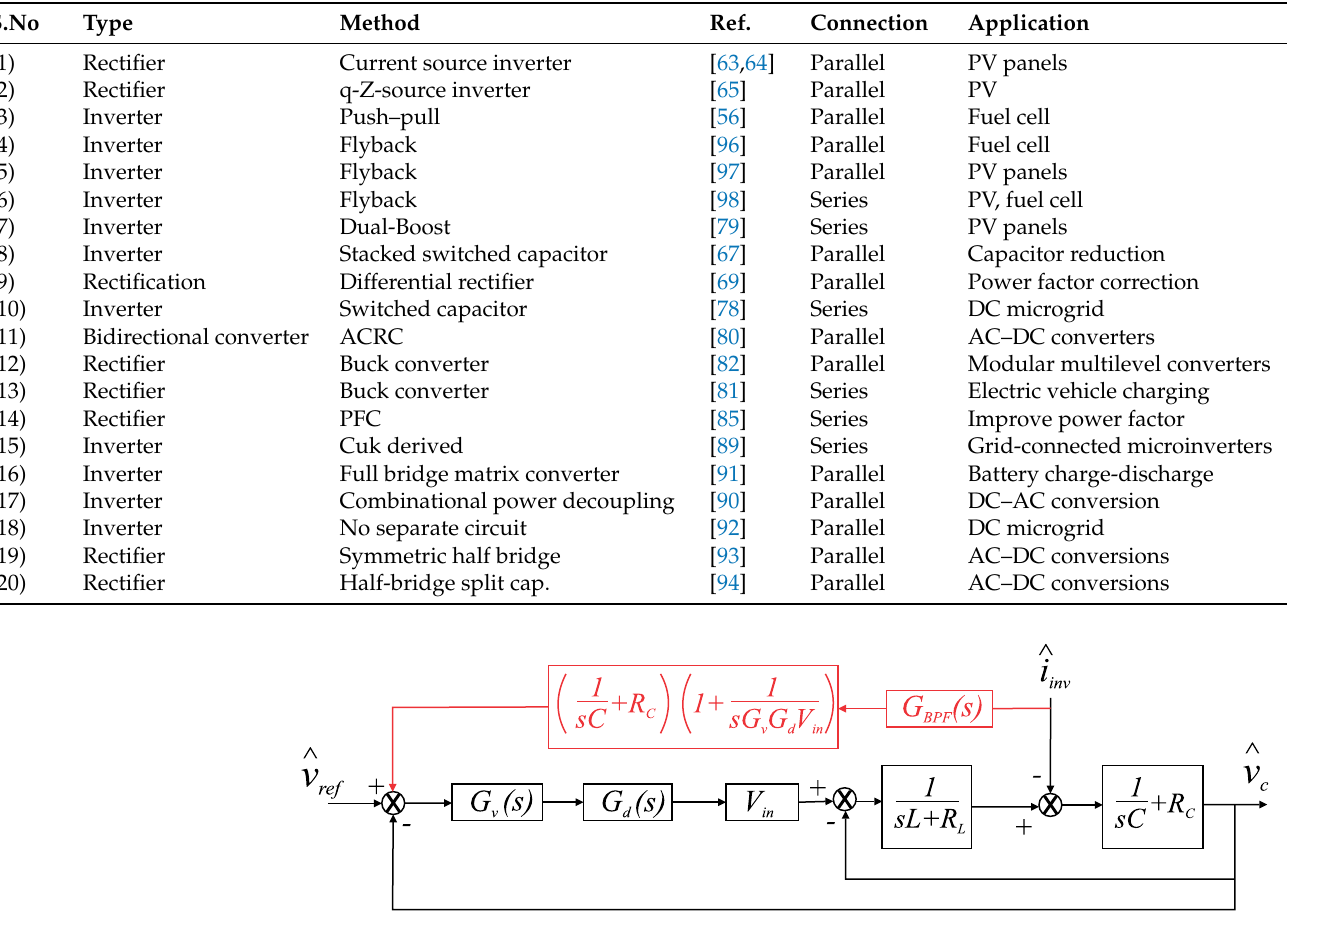
Figure 20. Load current feedforward